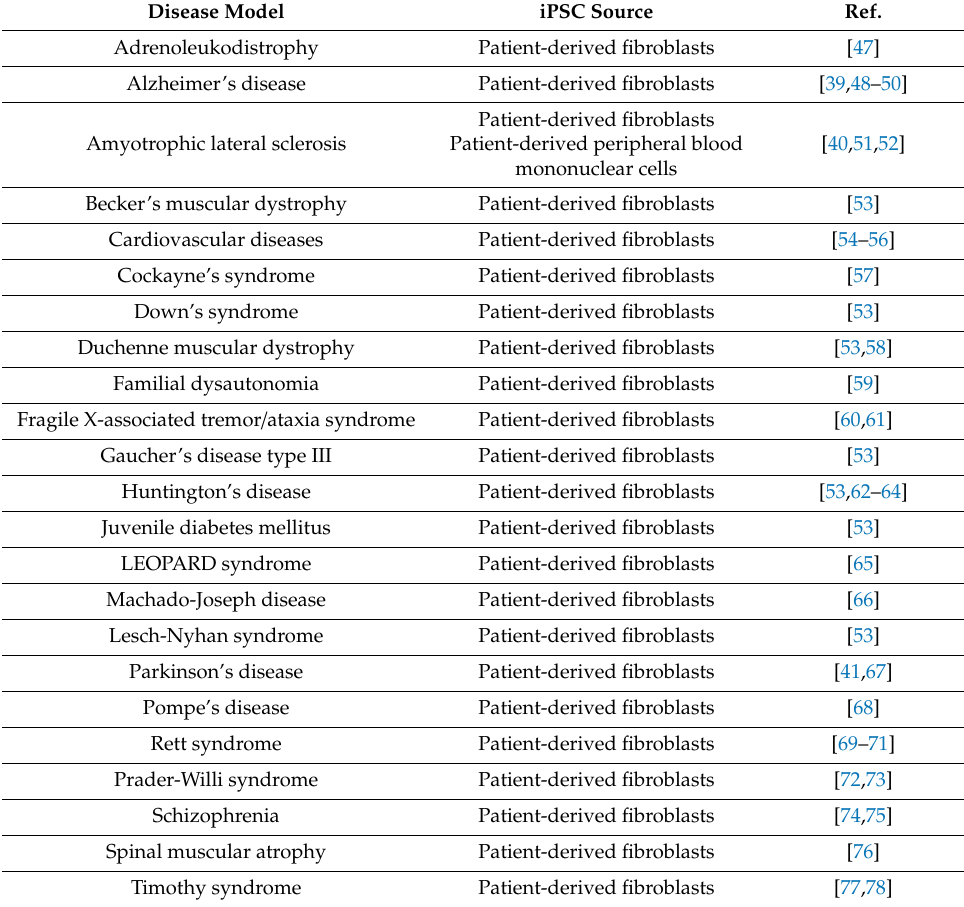
Table 2. List of human iPSCs disease